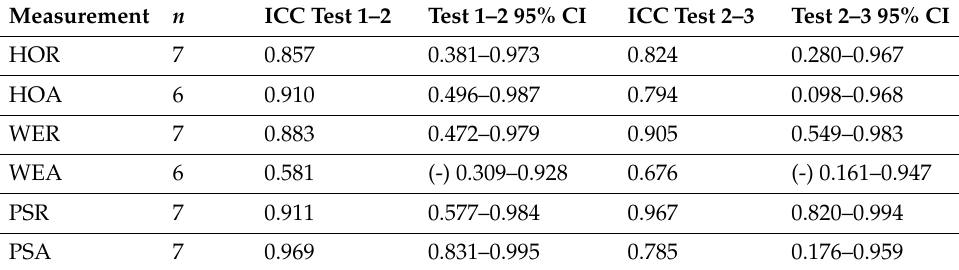
Table 2. Agreement between scores collected across testing